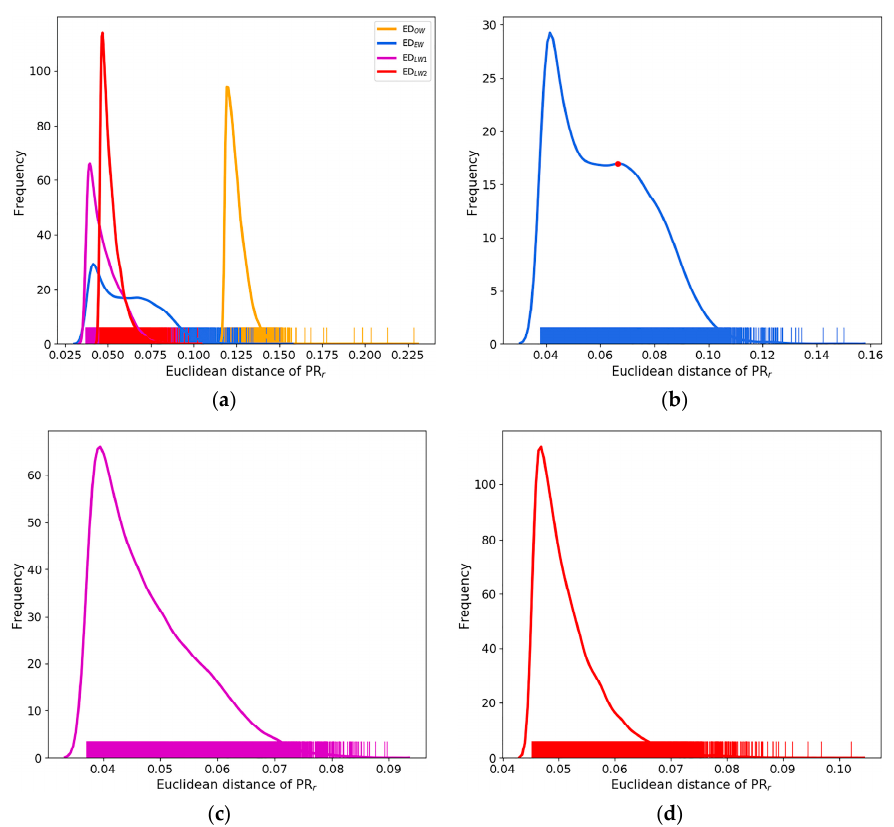
Figure 7. Distribution of ED between oil spill, emulsion, or low wind area and ordinary seawater based on PR r images, including KED curve and rug plot. ED OW , ED EW , ED LW 1 , and ED LW 2 in ( a ) correspond to Cases 2, 3, 5, and 6, respectively. The ED distributions corresponding to Cases 3, 5, and 6 are shown in ( b – d ), respectively. The red dot indicates the second peak in the KDE curve for the oil–water mixture, with a value of 0.0665.